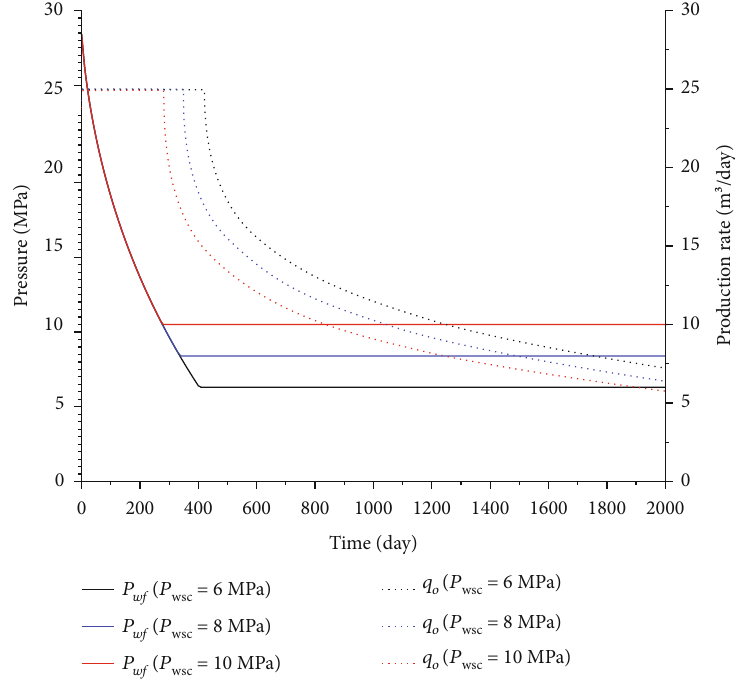
Figure 17: E ff ect of limiting wellbore pressure on well performance curve (compound working